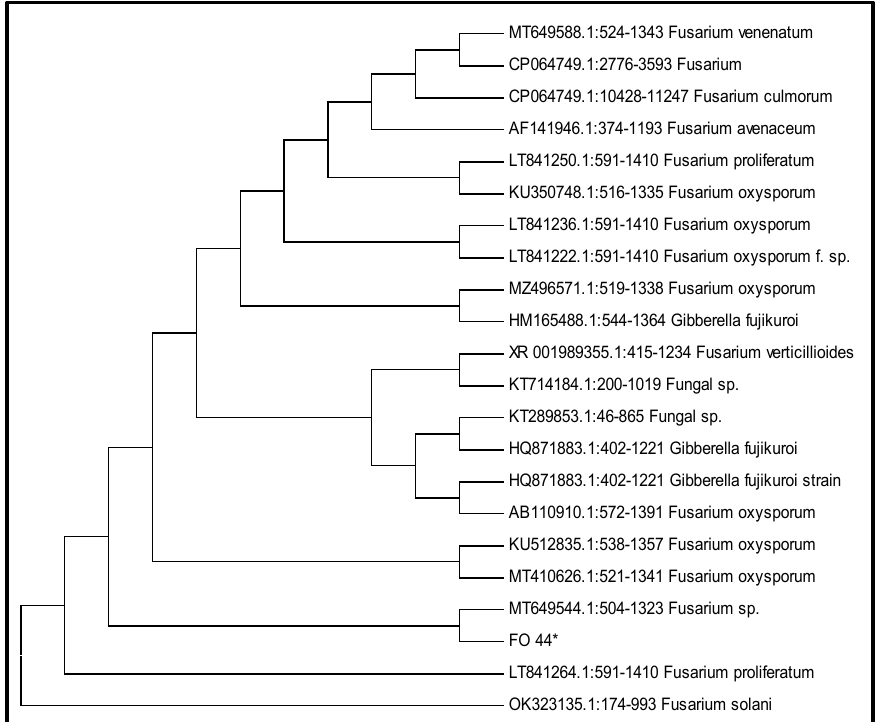
Figure 2. Evolutionary relationship of isolated Fusarium oxysporum strain FO_44, with 21 closely related GenBank sequences.